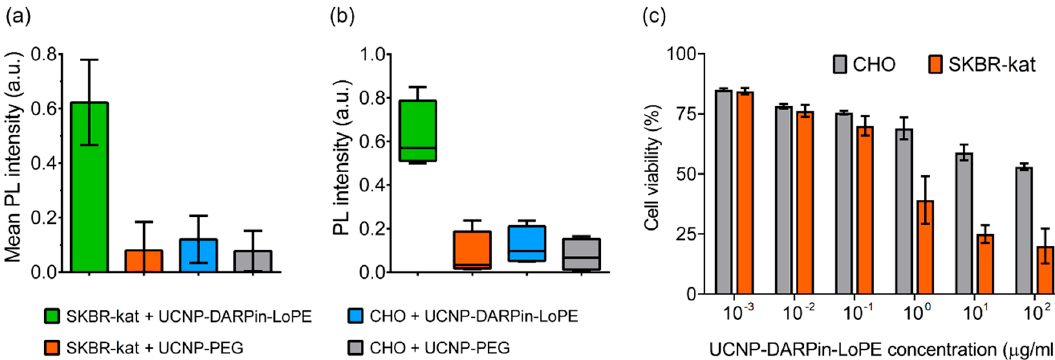
Figure 3. Interaction of non-targeted UCNP-PEG and UCNP-DARPin-LoPE theranostic nanocomplexes with cancer cells. Mean PL intensity of SKBR-kat and CHO cells labeled by UCNP- PEG/UCNP-DARPin-LoPE ( a ), Diagram of the range by groups ( b ). The dependence of the viability of CHO (HER2–) and SKBR-kat (HER2+) cells on the UCNP-DARPin-LoPE nanocomplexes concentration. Incubation time 96 hours ( c ).